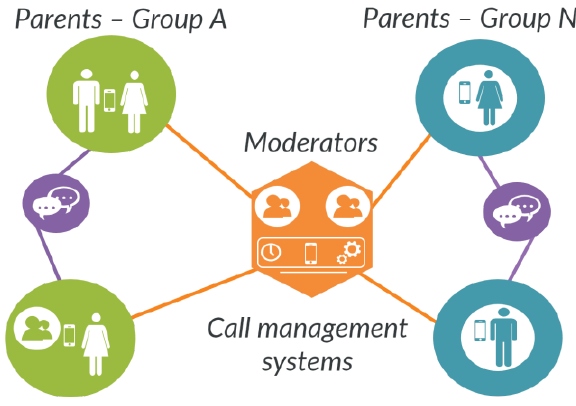
Figure 2. A (digitized) version of a sketch by our PD participants outlining the basics of the voice-based peer-to-peer support system. This schematic diagram depicts parental groups connected to each other through moderated conversations that can facilitate peer-to-peer learning and information